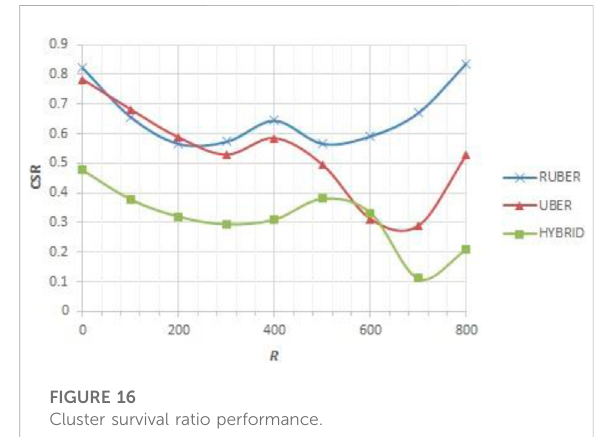
FIGURE 15 Route failure recovered performance.